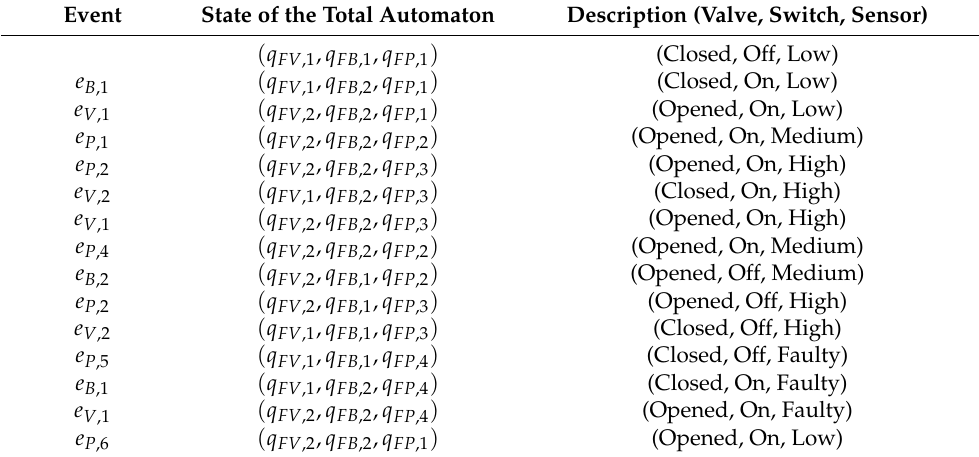
Table 1. A simulation of the transitions of the total